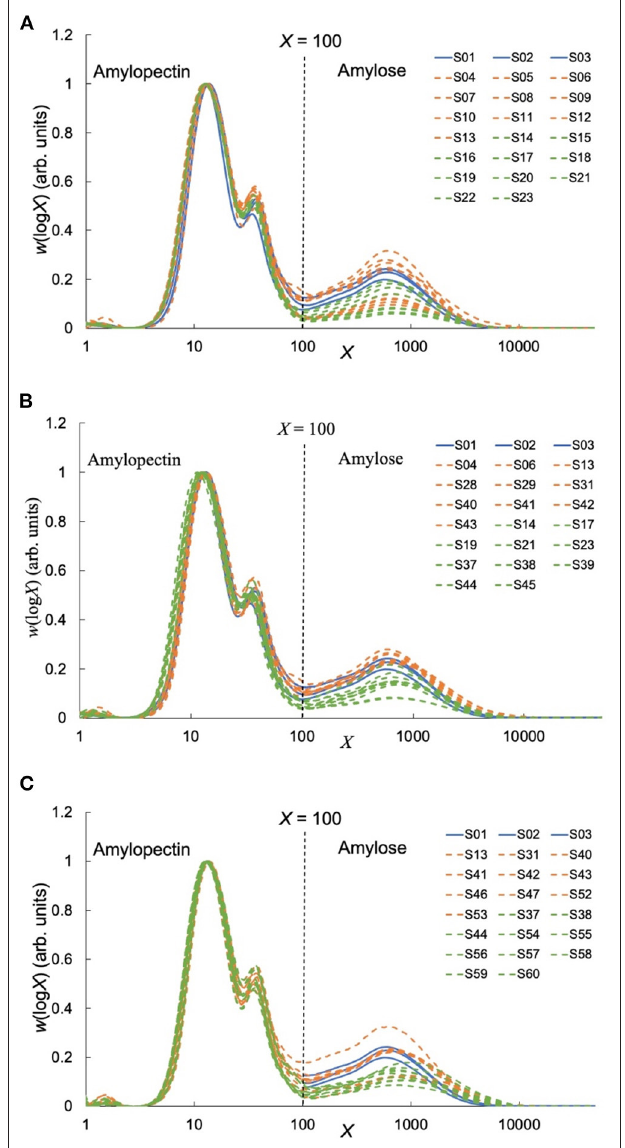
FIGURE 1 | Size-Exclusion Chromatography (SEC) results. Values of w (log X ), of debranched starch from AWRs and DRs. (A) Results used to build structure-thermal properties relations, (B) results used to build structure- in vitro digestion properties relations, (C) results used to build structure-textural properties relations. The debranched DR starch data obtained under the same conditions as the AWR starches are retrieved from the literature ( Supplementary Table 1 ). AWRs consist of S01–S03, indica variety contains S04–S13, S28–S29, S31, S40–S43, S46–S47, S52–S53 and japonica